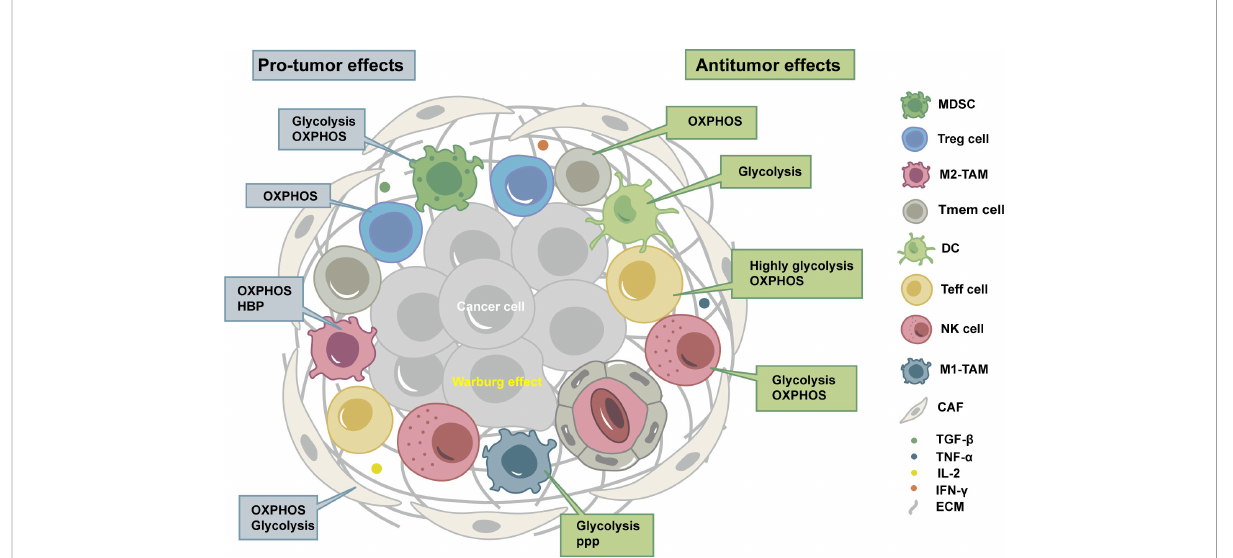
FIGURE 1 Tumor microenvironment (TME) is composed of tumor cells, immune cells, stromal cells, extracellular matrix, and exosomes, thus forming a microenvironment with the characteristics of in fl ammation, hypoxia, acidity, and immunosuppression. Different types of cells in TME have their preferred metabolic phenotypes. OXPHOS, oxidative phosphorylation; HBP, hexosamine biosynthesis pathway; PPP, pentose phosphate pathway; MDSC, myeloid-derived suppressor cell; Treg cell, regulatory T cell; M2-TAM, immunosuppressive macrophages; Tmem cell, CD8 + memory T cells; DC, dendritic cell; Teff cell, CD8 + effector T cells; NK cell, natural killer cell; M1-TAM, in fl ammatory tumor-associated macrophages; CAF, cancer-associated fi broblast; TGF- b , transforming growth factor- b ; TNF- a , tumor necrosis factor- a ; IL-2, Interleukin-2; IFN- g , Interferon- g ; ECM, extracellular